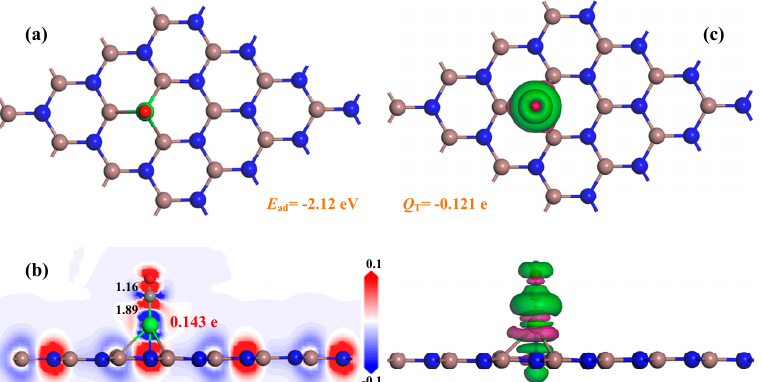
Figure 2. Total DOS ( a ) and partial DOS ( b ) of Pd-InN. The dash line is the Fermi level.